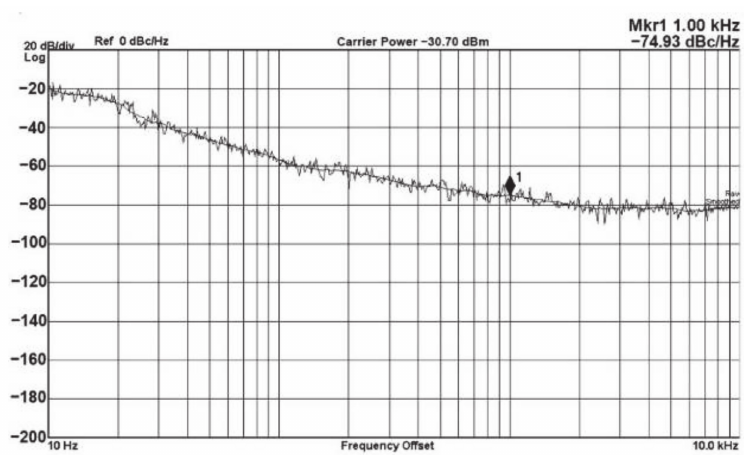
Figure 26. Measured result of the phase noise.